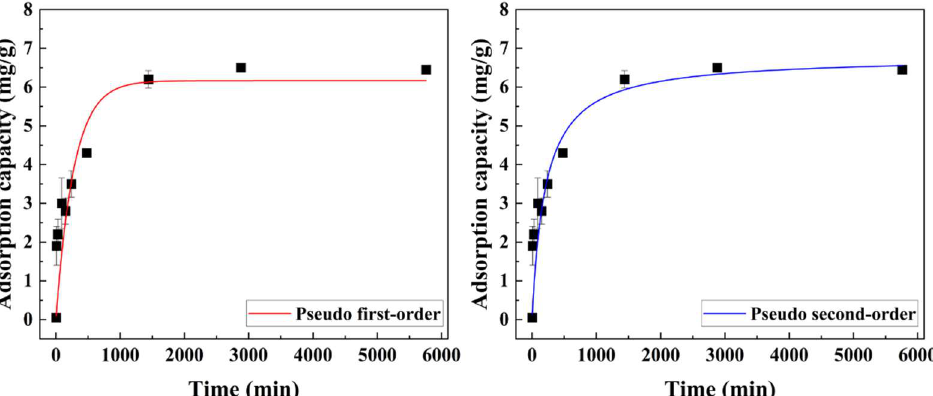
Figure 6. Iodide adsorption kinetics of Alg–BO and results of nonlinear fitting using pseudo-first- (red line) and pseudo-second-order (blue line) models. Initial iodide concentration = 20 mg/L; adsorbent concentration ≈ 1.4 g/L; contact time = 5–5760 min.